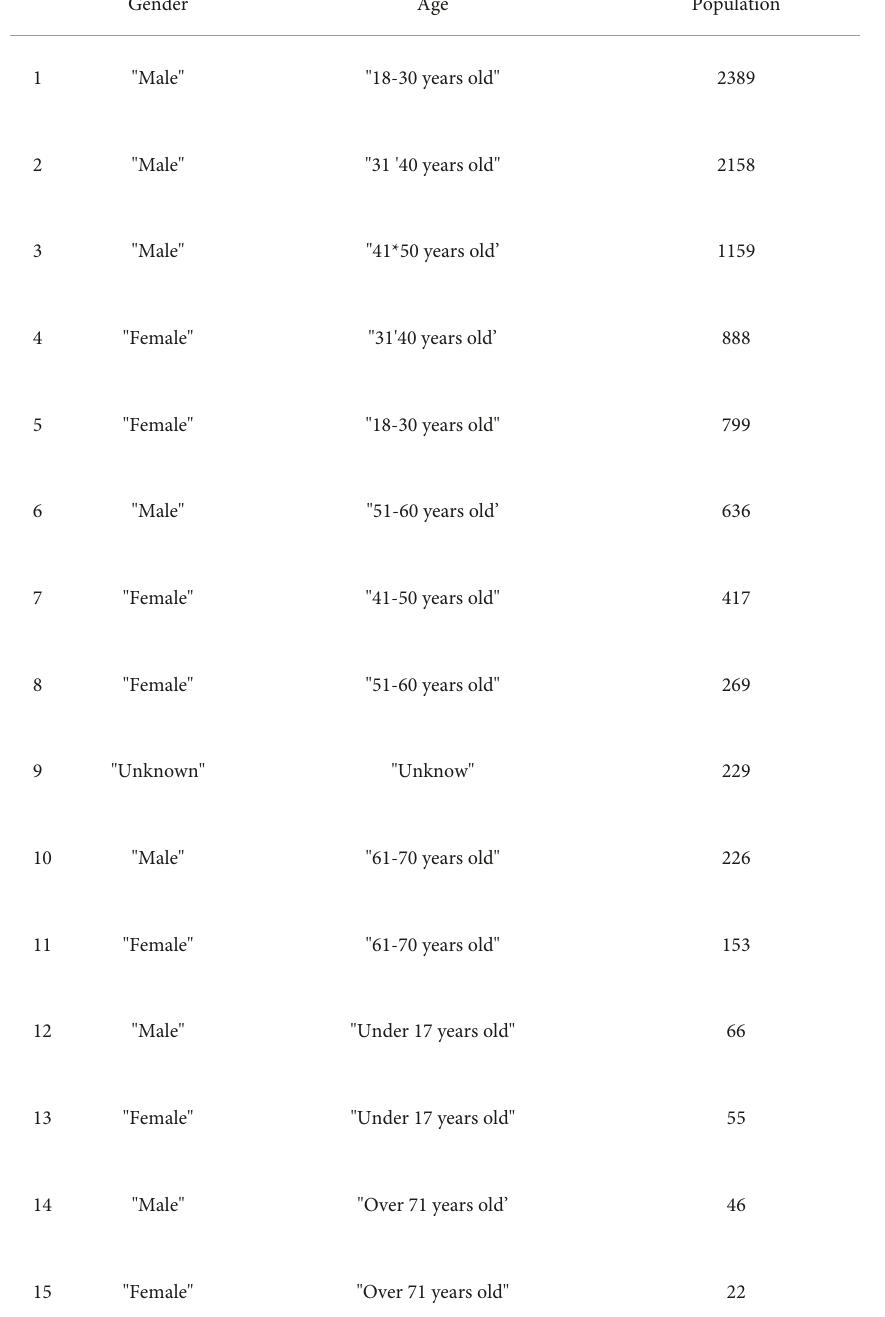
Figure 12: Gender and age distribution of accident